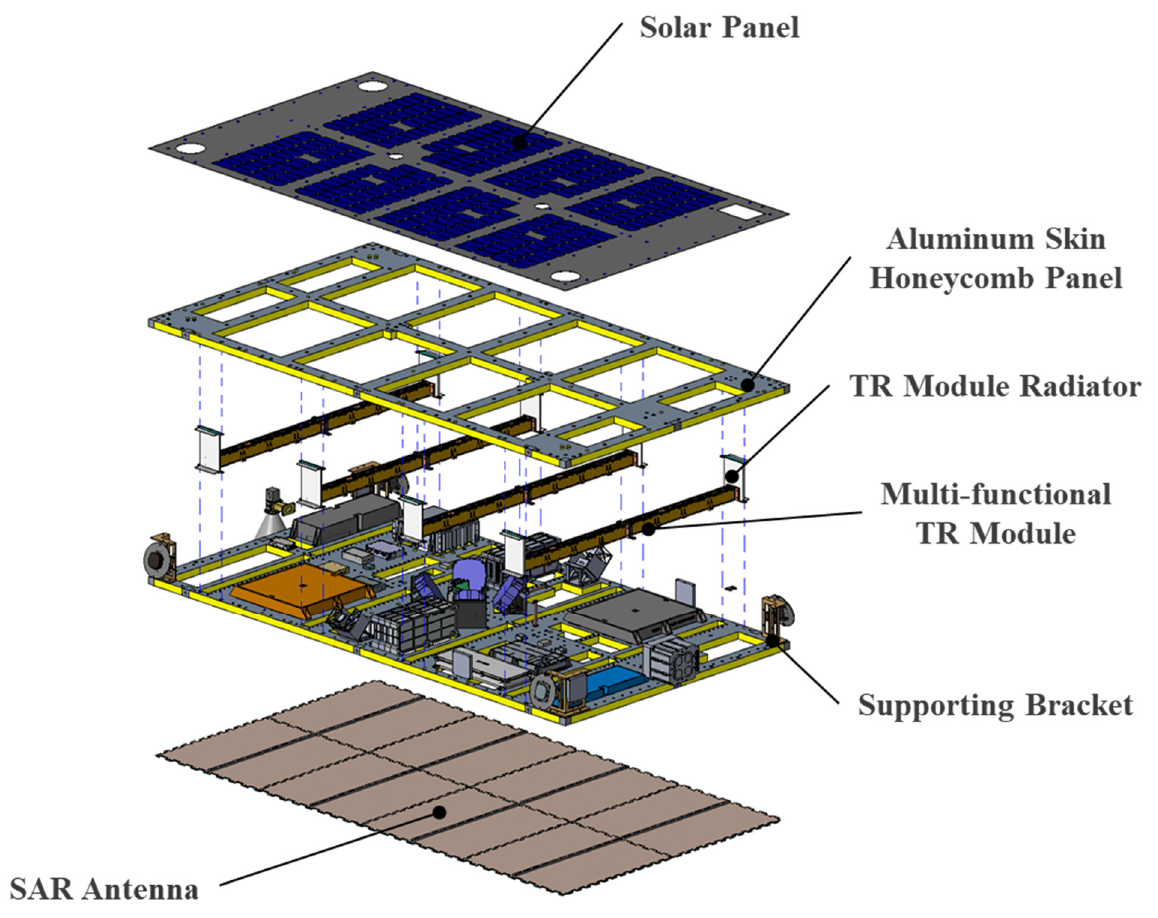
Figure 5. Exploded view of the S-STEP system.